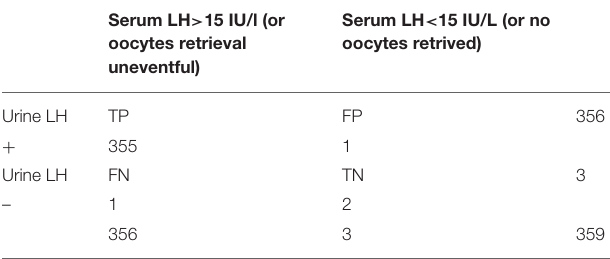
TABLE 3 | Summary of parameters of urinary LH test: true-positive rate (sensitivity) 355/356 = 99.7%; false-positive rates (1-specificity) 1/3 =